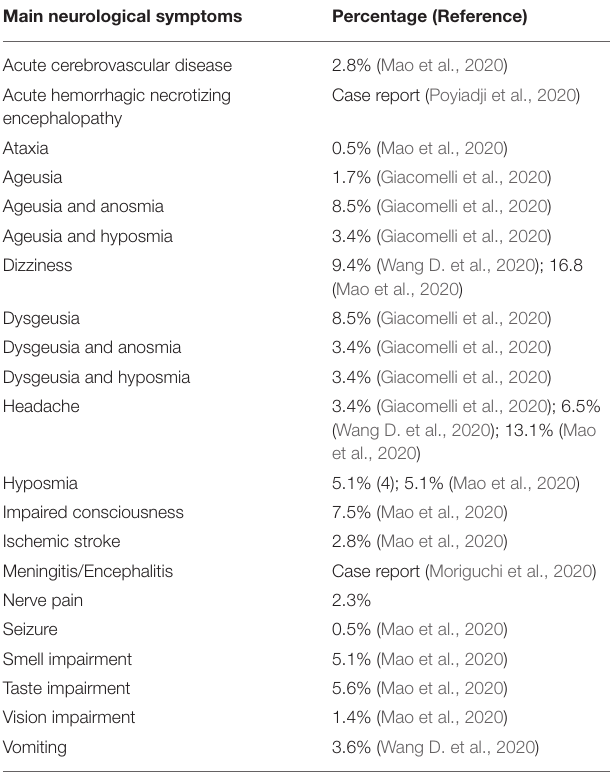
TABLE 1 | Percentages of patients with COVID-19 that suffered from neurological symptoms, considering the studies included in the current